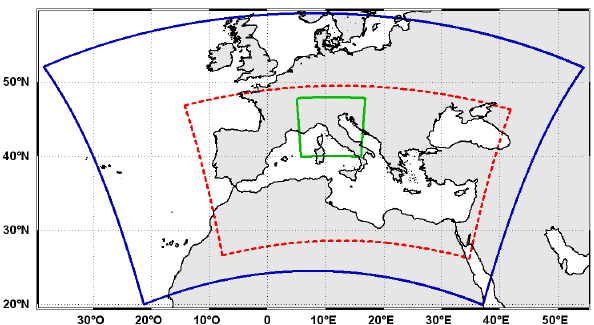
Figure 1. SIMM: model domain for the 0.1 ◦ BOLAM (red dashed line), the 0.07 ◦ BOLAM (blue solid line) and the 0.0225 ◦ MOLOCH (green solid